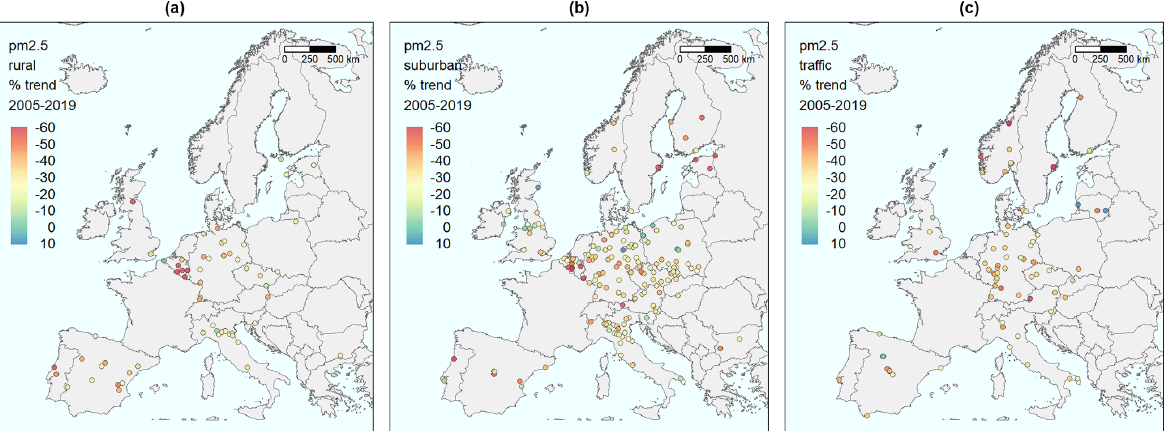
Figure 11. Maps of stations in Europe with the percentage change in expected concentrations from 2005 to 2019, relative to the initial level in 2005, based on the meteorology-adjusted trend for PM 2 . 5 . (a) Background stations in rural areas. (b) Background stations in urban/suburban areas. (c) Traffic